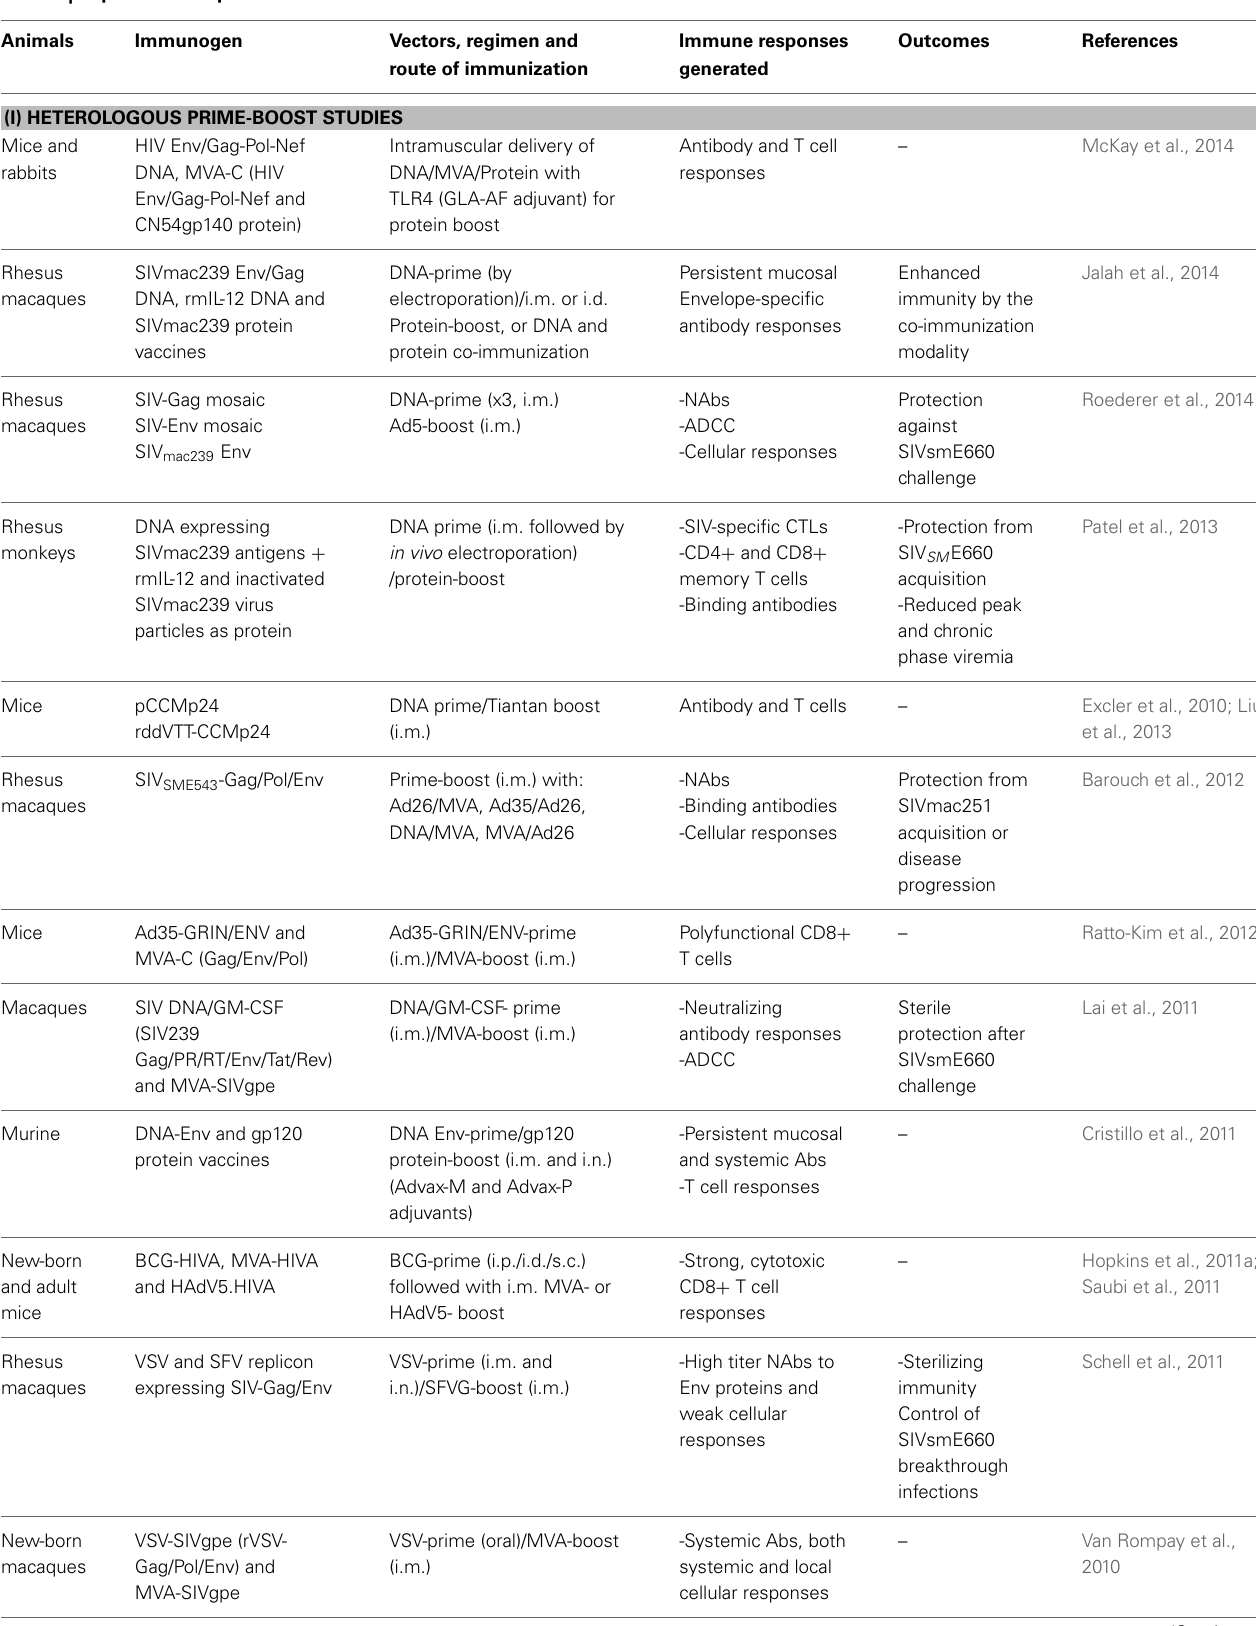
Table 2 | Representative preclinical studies.